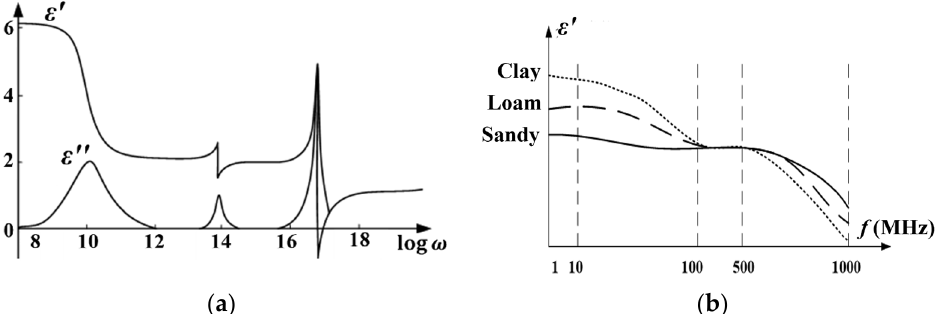
Figure 3. Dielectric constant frequency characteristics. ( a ) Dielectric loss; ( b ) loamy di ff erences.